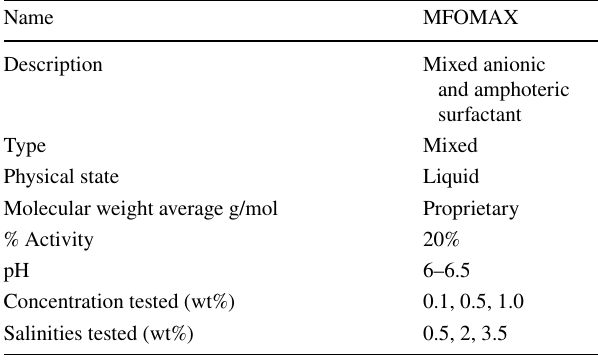
Table 2 Properties of surfactant used in this